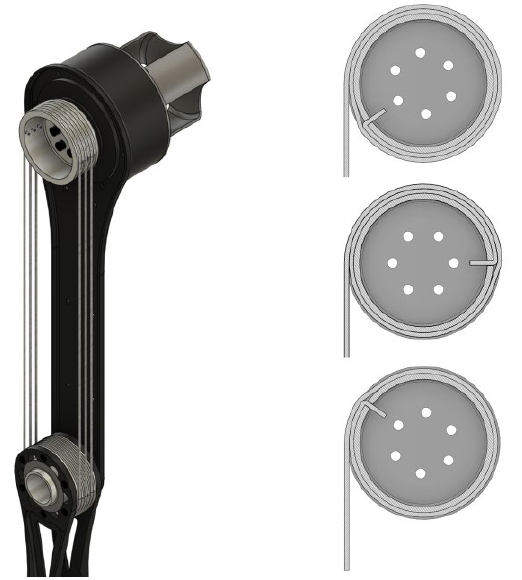
Figure 5. The roped transmission structure. The radius does not change in the designed activities.